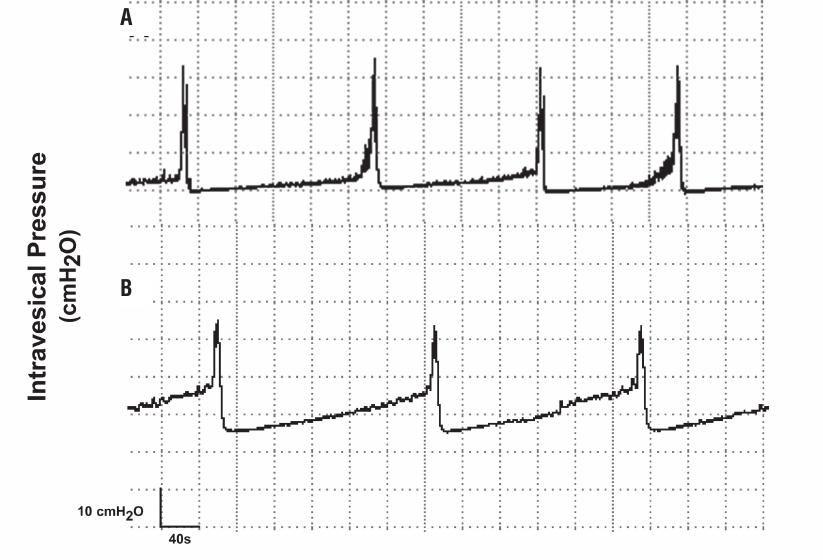
Figure 1 – Representative cystometric recordings of female Wistar rats which underwent bladder autotransplant. Non- operated rat (A) and rat 30 days after bladder autotransplant (B). The autotransplanted rat showed detrusor contractions, with amplitude of maximal pressure, micturition intervals and micturition duration similar to the normal rat. The threshold of the intravesical pressure was partially increased when compared with the recording of non-operated rat.